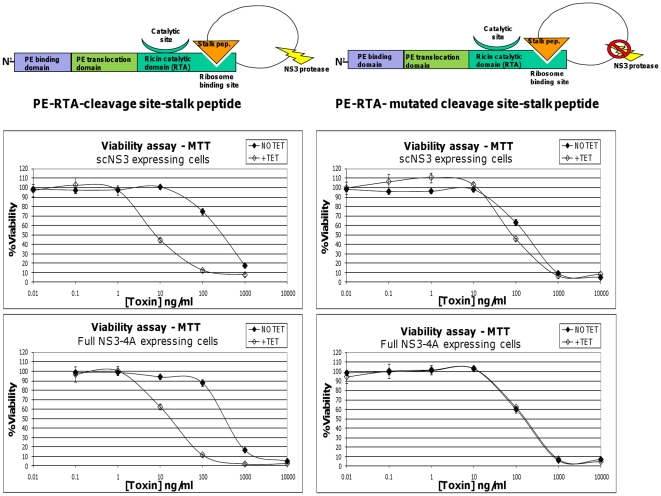
Viability assay of NS3 expressing cells treated with RTA based zymoxins.T-Rex cells inducibly expressing scNS3 or full NS3-4A were seeded (4×104 cells per well) in 96-well plates. After 9 hours, cells were treated with 1µg/ml of tetracycline (+TET) or left untreated (NO TET). Two hours later, cells were incubated for 72 hours with serial dilutions of the toxins “PE-RTA-cleavage site-stalk peptide” or “PE-RTA- mutated cleavage site-stalk peptide” (presence of tetracycline was kept in the growth media of induced cells). The relative fraction of viable cells was determined using an enzymatic MTT assay. A representative graph of three independent experiments is shown. Each point represents the mean ±SD of a set of data determined in triplicates.